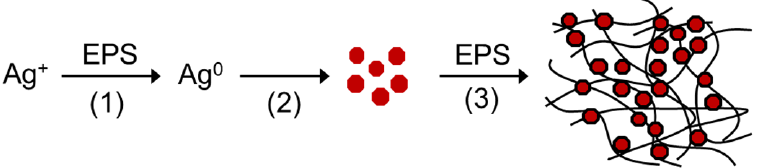
Figure 4. Mechanism for formation and stabilization of AgNO 3 with EPS: ( 1 ) reduction of Ag+ to Ag atoms; ( 2 ) crystallization of Ag atoms to Ag NPs; ( 3 ) capping of Ag NP by EPS and adsorption of Ag NPs to EPS networks.